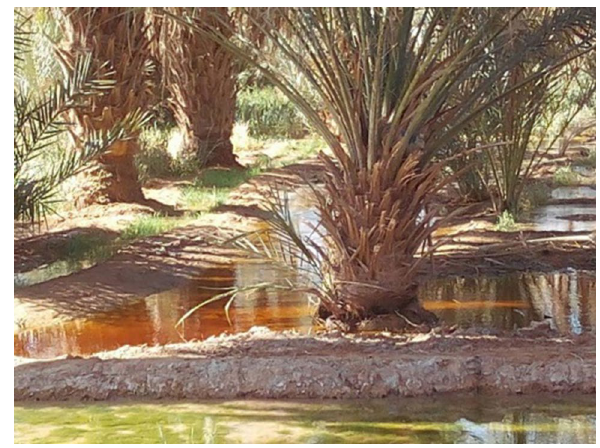
Fig. 15 Flooding of the Yellou palm grove. (photo. Authors 2018)